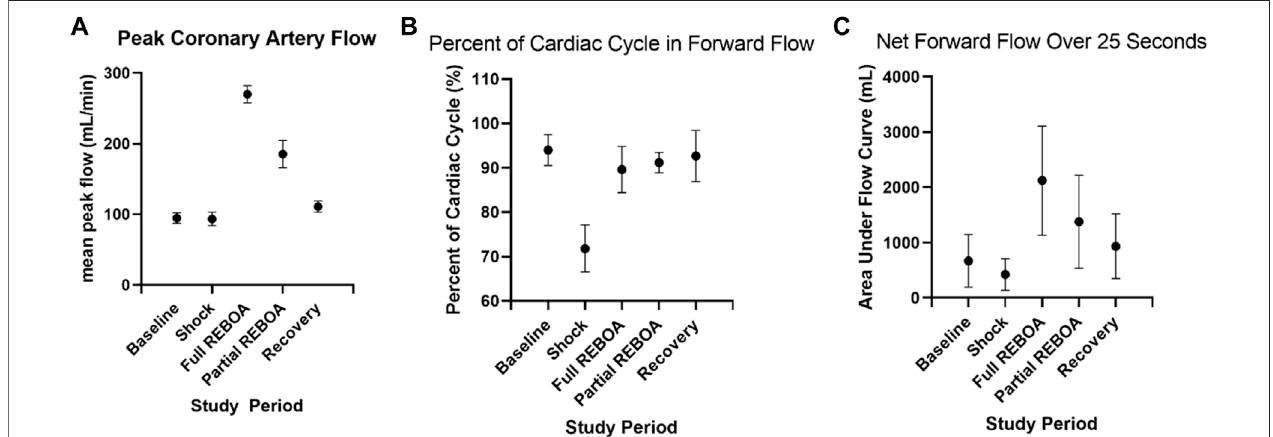
FIGURE7| Coronarywaveformanalysisacrossstudyperiods. (A) . Peakcoronary artery fl owrateduring each studyperiod for allanimals. (B) .Thepercent oftime spent in antegrade coronary fl ow during each study period, where fl ow is reversed more frequently in shock, but is rescued by REBOA. (C) . Total net left coronary fl ow during each study period, over 25 s